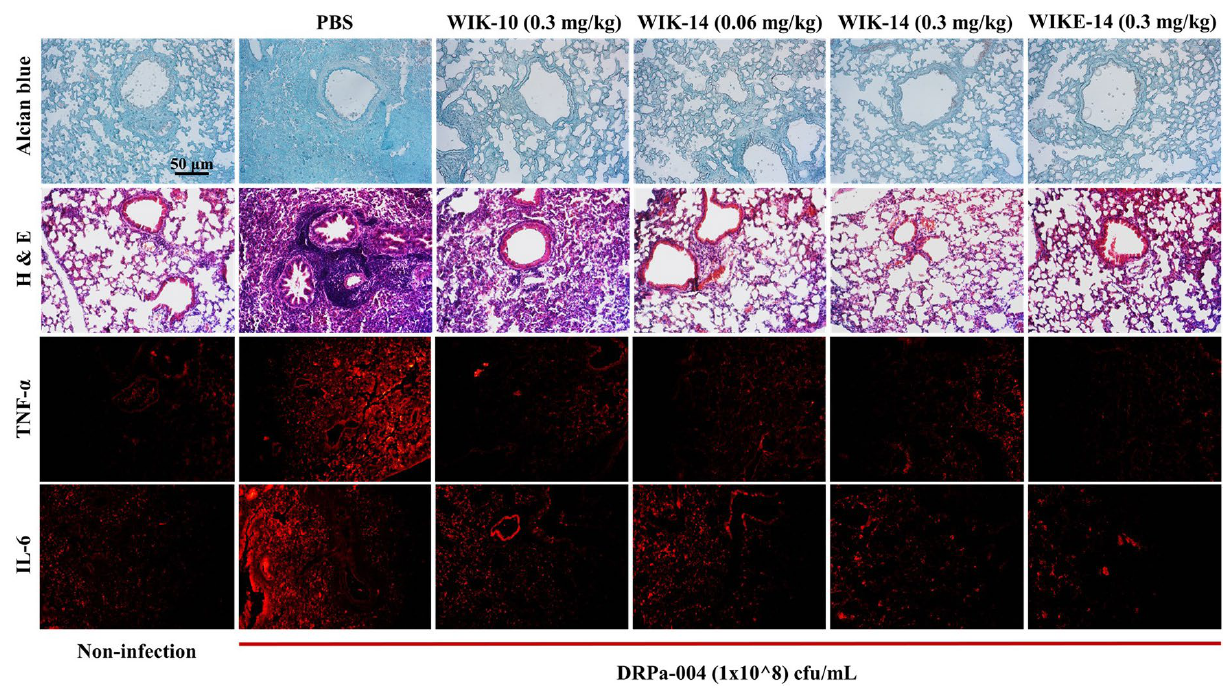
Figure 8. In vivo antibacterial effects of WIK-10, WIK-14, and WIKE-14 peptides. After 1 h treatment with DRPa (1 × 10 8 cfu/mL) by intratracheal (i.t.) administration, Balb/c mice that were treated with PBS and the indicated peptides (n = 4) by i.t. administration were euthanized after three days. In- flammatory effects of the peptides were examined by immunohistology using lung tissues of P. aeruginosa -induced pneumonia mice. TNF- α and IL -6 were detected using monoclonal PE-label an- tibody.